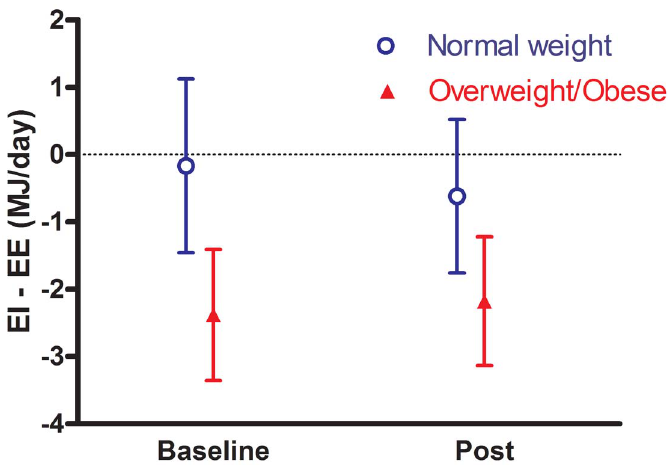
Figure 2. Error bars illustrating mean difference (95% CI) between energy intake (EI) and energy expenditure (EE) in normal weight and overweight/obese participants.